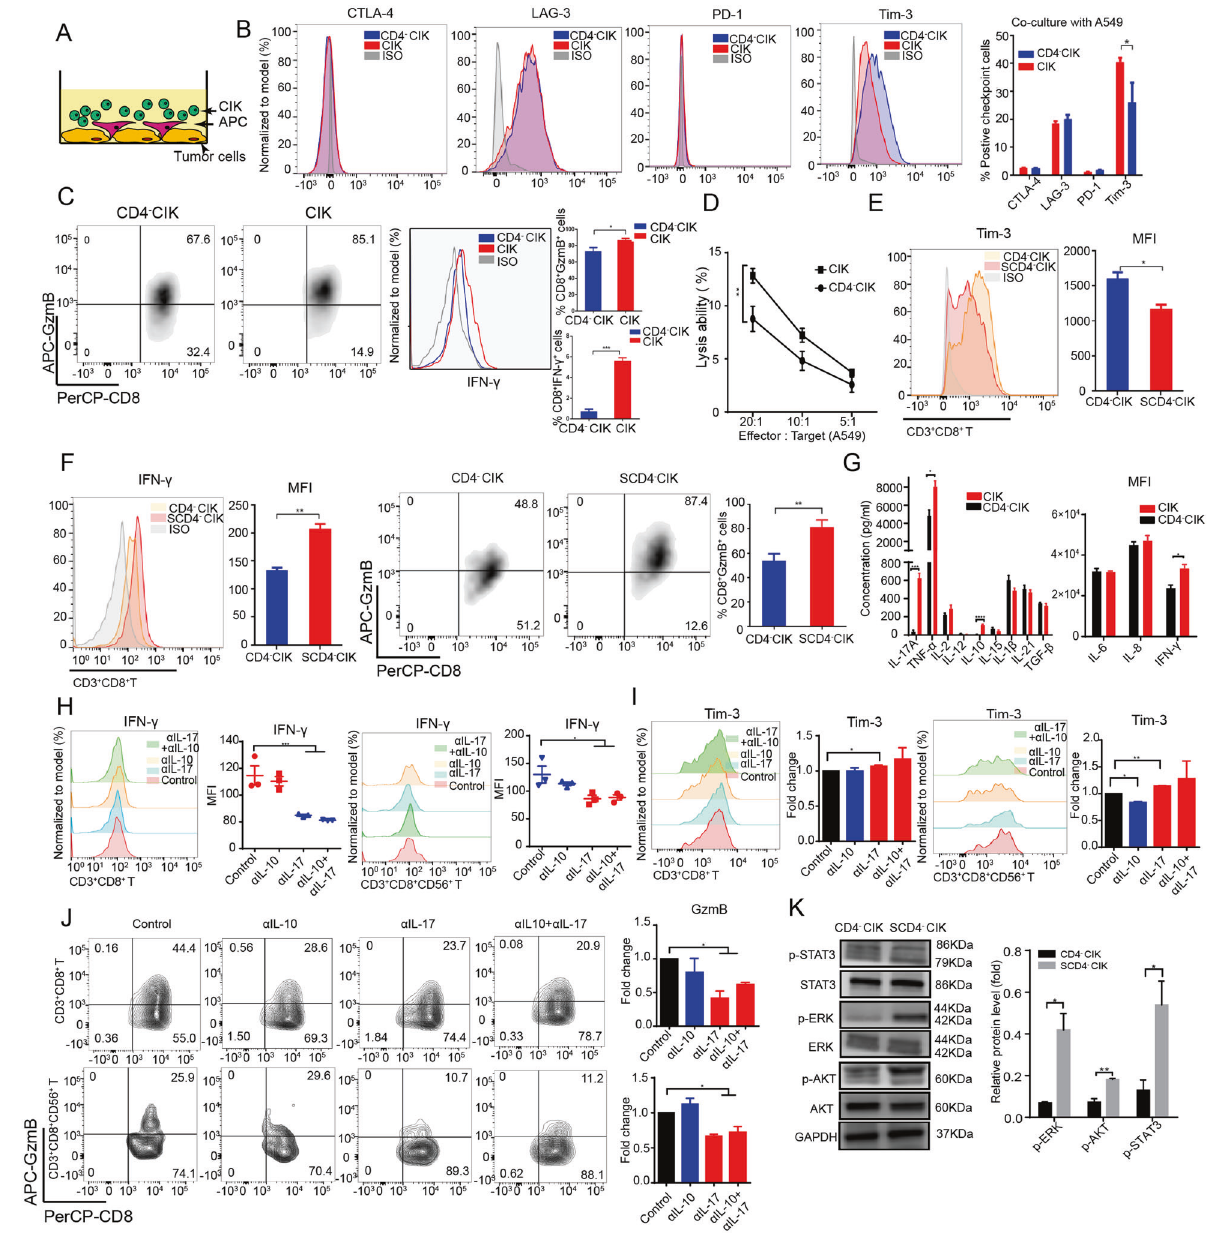
Fig. 4 The supernatants of CD4 + T cell culture improved the functions of CIK cells in vitro. A Illustration of co-culture of tumor cells (A549 and H520) and CIK cells. B Flow cytometric analysis of PD-1, CTLA-4, Tim-3, and LAG-3 expression in CD3 + CD8 + T cells in a co-culture system (A549). C Flow cytometric examination of GzmB and IFN- γ production in CD3 + CD8 + T cells in a co-culture system (A549). D The cytotoxicity of CIK or CD4 − CIK cells against A549. E , F Flow cytometric assessment of Tim-3, IFN- γ , and GzmB expression in CD3 + CD8 + T cells treated with tumor-conditioned medium in the presence (SCD4 − CIK group) or absence (CD4 − CIK group) of CD4 + T cells. G Flow cytometric or ELISA assessment of the concentration or MFI of 12 human in fl ammatory cytokines in tumor-conditioned medium in the presence or absence of CD4 + T cells. H – J Flow cytometric analysis of Tim-3, IFN- γ , and GzmB expression in CD3 + CD8 + T or CD3 + CD8 + CD56 + T cells treated with either PBS, anti-IL-10 (200 ng/ml), or anti-IL-17 (100 ng/ml). K Western blot analysis of STAT3, AKT, and ERK phosphorylation in CD4 − CIK cells treated with tumor-conditioned medium for 2 h. Error bars indicate SEM, * P < 0.05, ** P < 0.01, *** P < 0.001, and **** P < 0.0001 (one-way ANOVA or Student's t